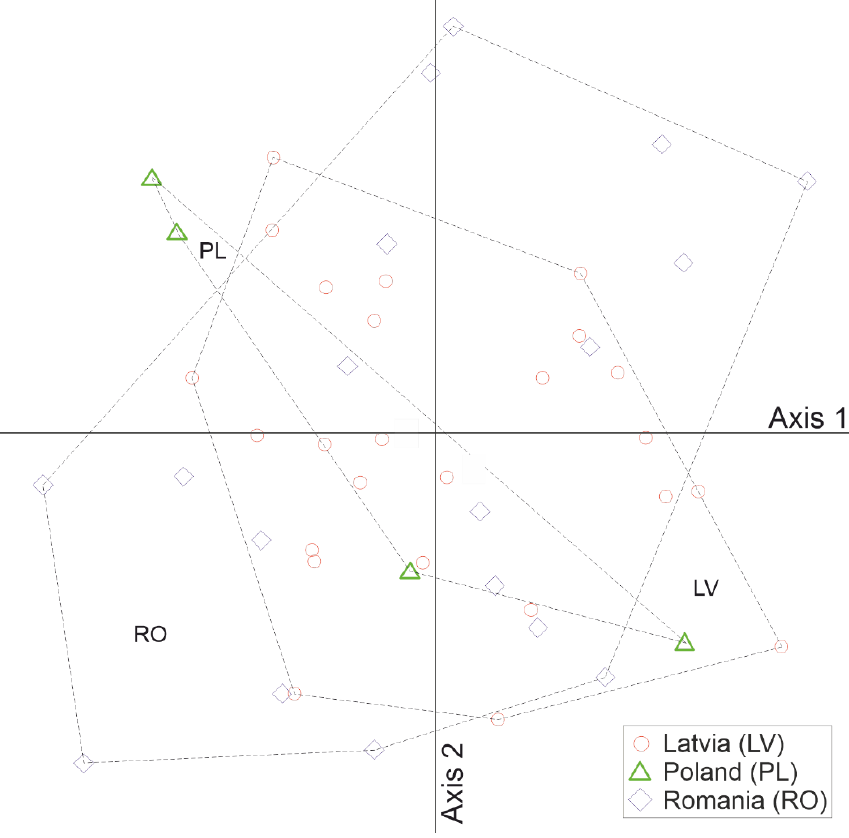
Figure 3. Ordination of the 47 pine, bog woodland communities under study after filtering out the spatial autocorrelation through unconstrained partial redundancy analysis. Community grouping as in Figure